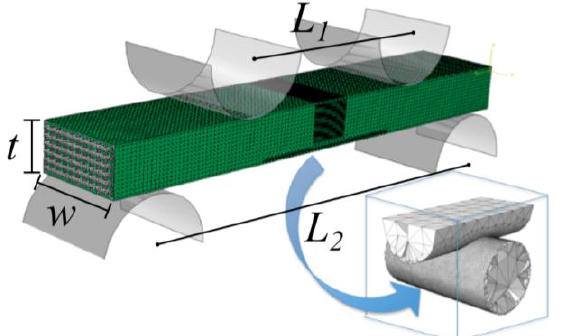
Figure 12. Finite element mesh used for the simulation of 4-point bending test on bare and polymer-impregnated scaffolds. The dimensions of the elements at the rod surfaces are around 100 μm, except in the central bottom region, shown in the inset, where the size is reduced to 5